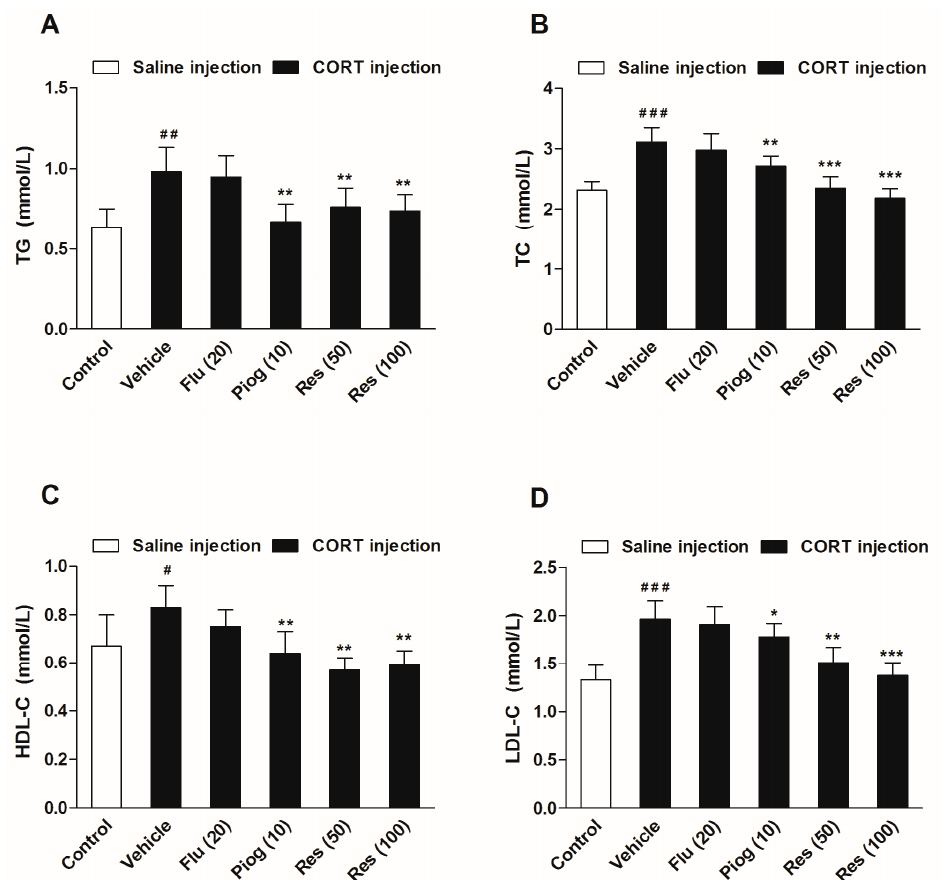
Figure 5. Effects of resveratrol on the serum lipid profiles in CORT- treated mice. ( A ) Serum level of TG; ( B ) Serum level of TC; ( C ) Serum level of HDL-C; ( D ) Serum level of LDL-C. Data were expressed as the mean ± S.E.M. ( n = 10). # p < 0.05, ## p < 0.01 and ### p < 0.001 vs . control group. * p < 0.05, ** p < 0.01 and